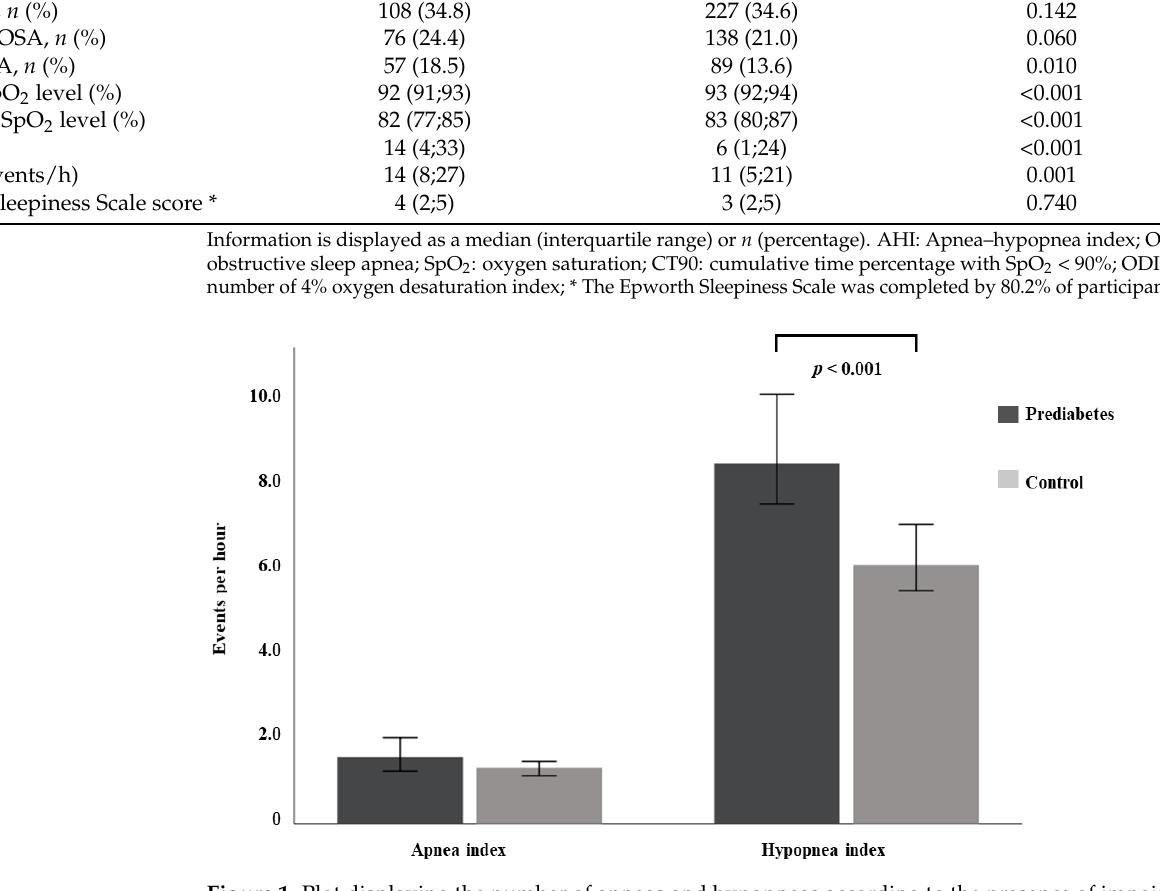
Figure 1. Plot displaying the number of apneas and hypopneas according to the presence of impaired glucose metabolism.